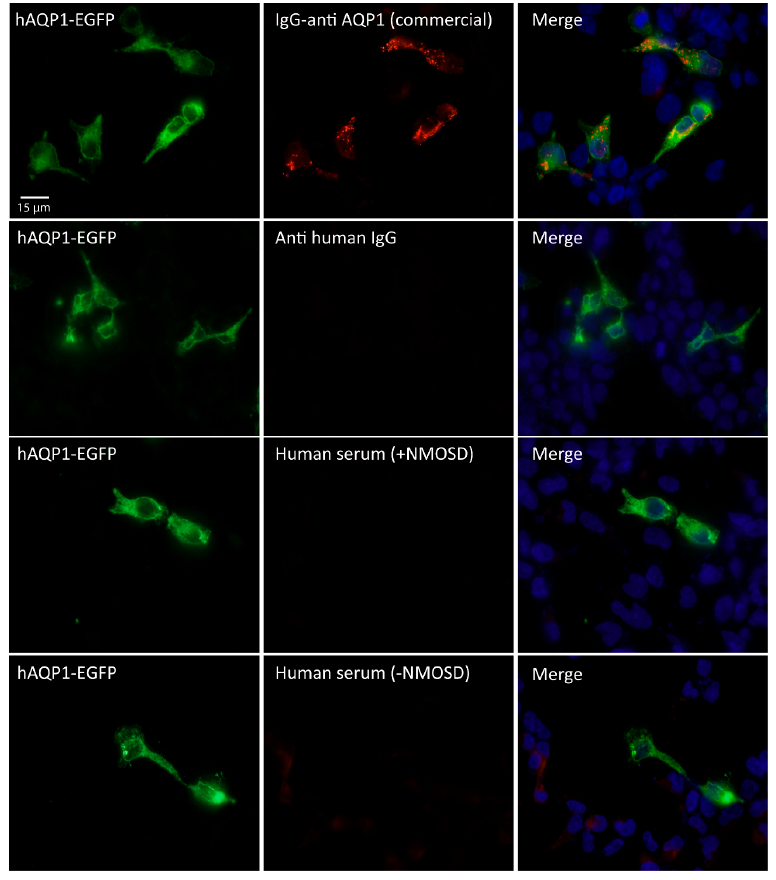
Figure 3. Immunofluorescence assay with commercial antibody for AQP1. HEK cells expressing AQP1 in green (left column) immune reacted with a commercial IgG-anti-AQP1 (top middle panel, red signal), using fixed cells and without triton permeabilization. A clear and specific immune reaction was detected only in cells expressing AQP1 (merge signal in orange, top right panel). Absence of IgG anti-AQP1 was revealed in all rest of conditions tested: with an anti-human IgG secondary antibody; with human serum from a patient with NMOSD (+NMOSD); and with human serum from a patient negative for NMOSD ( − NMOSD). Merge of fluorescence signal can only be seen when the commercial antibody for AQP1 was used (orange/yellow signal, top right panel). Scale bar = 15 µm.